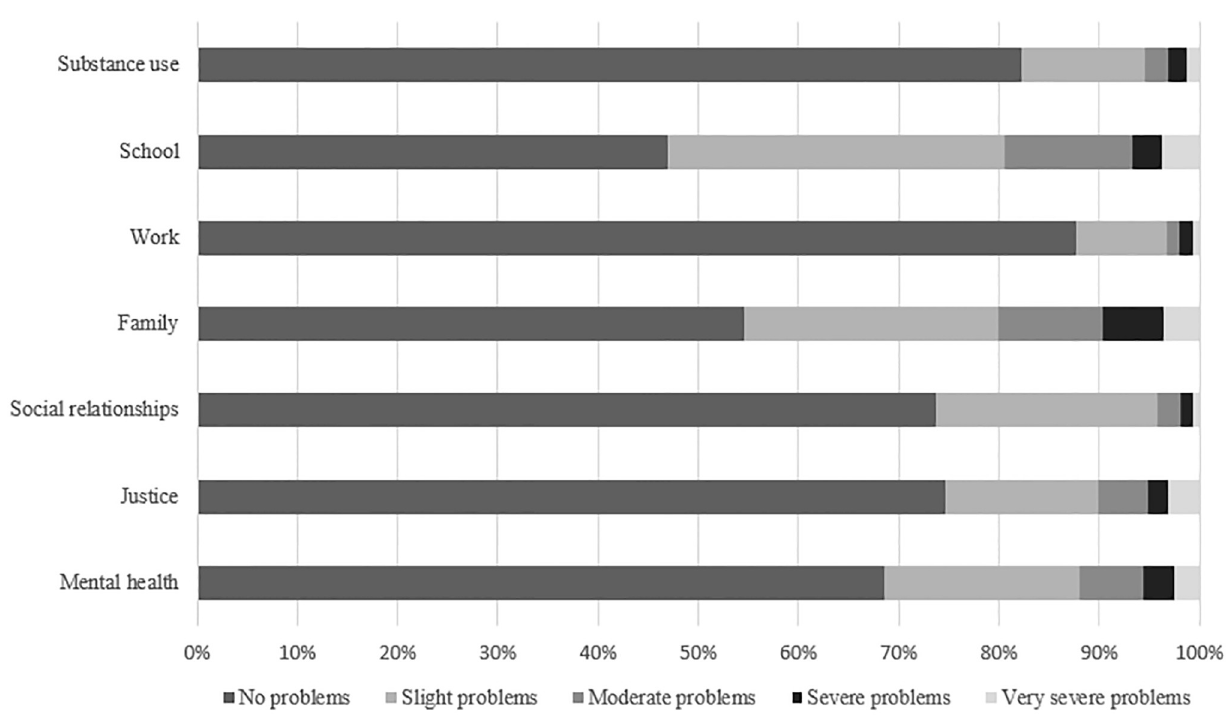
Fig 1. Frequency of problems reported by respondents (in % of total) in the ASC T-ASI domains. https://doi.org/10.1371/journal.pone.0238858.g001 Convergent validity. Positive correlations of moderate strength were found between the ASC T-ASI domain mental health and the EQ-5D-3L dimension anxiety/depression (r = 0.466). Positive correlations of moderate strength were 0.304) and SDQ difficulties score (r s also found between the ASC T-ASI domain social relationships and the SDQ dimension peer relationship problems (r = 0.408) and between the ASC T-ASI and EQ-5D-3L tariffs (r s 0.350). A negative correlation of moderate strength was found between the ASC T-ASI tariff Table 3. Mean (SD) ASC T-ASI and EQ-5D-3L tariffs, and SDQ difficulties score of adolescents who do (not) use substances and/or are (not) delinquent a